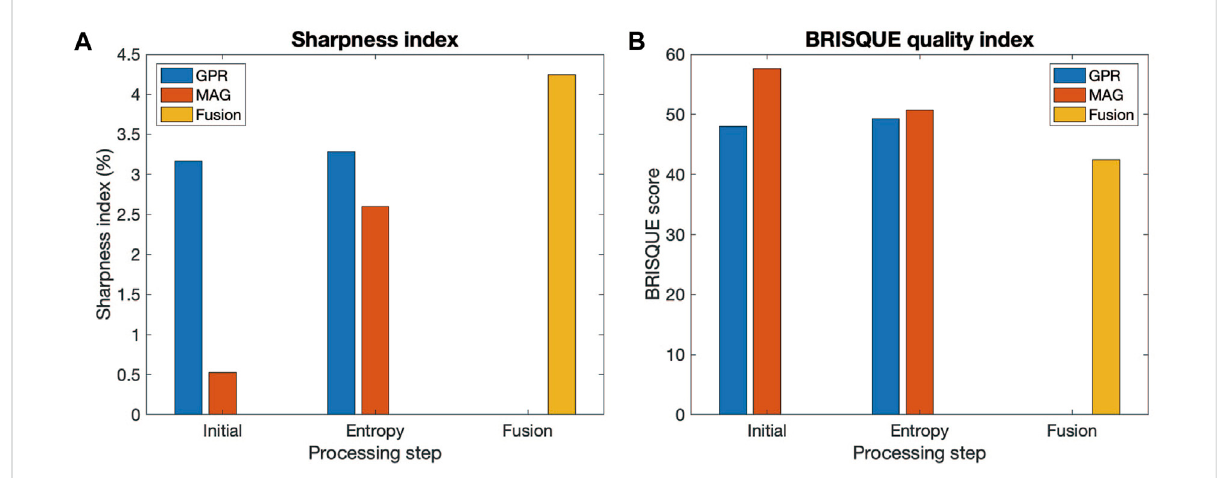
FIGURE 13 Graphical representation of the evolution of the sharpness index (A) and the BRISQUE quality index (B) of the data considered in the several stages of the data fusion.